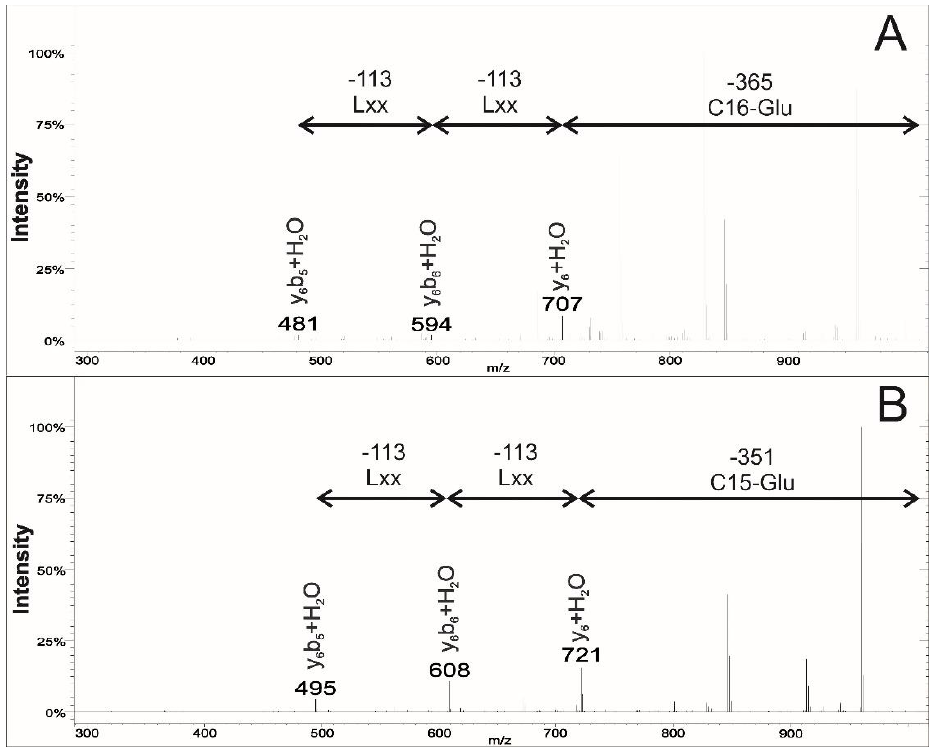
Figure 4. The characteristic fragment ions of C16-[Sur] ( m / z 1072, 30 ; ( A )) and C15-[AME5] ( m / z 1072, 29 , ( B )) resulted via internal fragmentation mechanism.